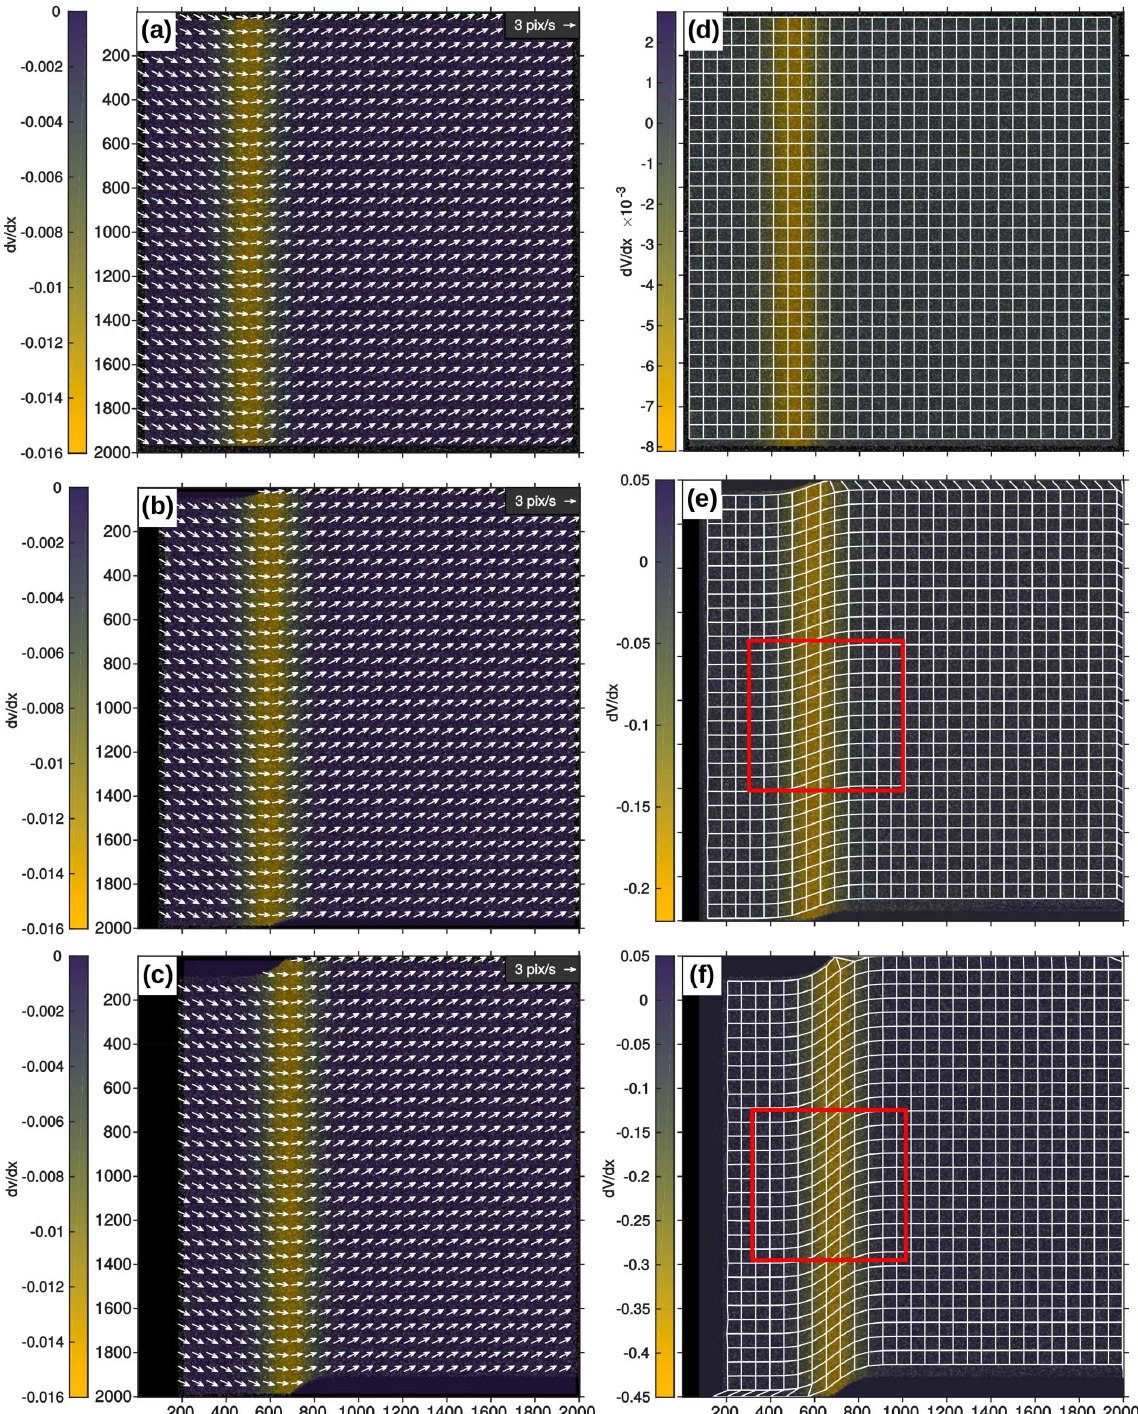
Figure 8. PIV results for the moving shear zone synthetic test. The u component of the imposed velocity is homogeneous. The v component changes sign across a shear zone that is advected with u . (a, b, c) Velocity vectors with the velocity gradient (cid:49)v/(cid:49)x at frames 10, 30 and 60. The location of the shear zone moves to the right over time. Vectors are plotted every four points in each direction for clarity. (c, d, e) Lagrangian sum of displacements at the same stages plotted as deformed grids. The deformed grid is plotted every four points in each direction for clarity. The scalar parameter is the gradient along the x axis of the cumulative displacement along the y axis: (cid:49)V/(cid:49)x . The magnitude of the gradient increases over time, but the shear zone width remains. The red box shows the area plotted in Fig. 12.